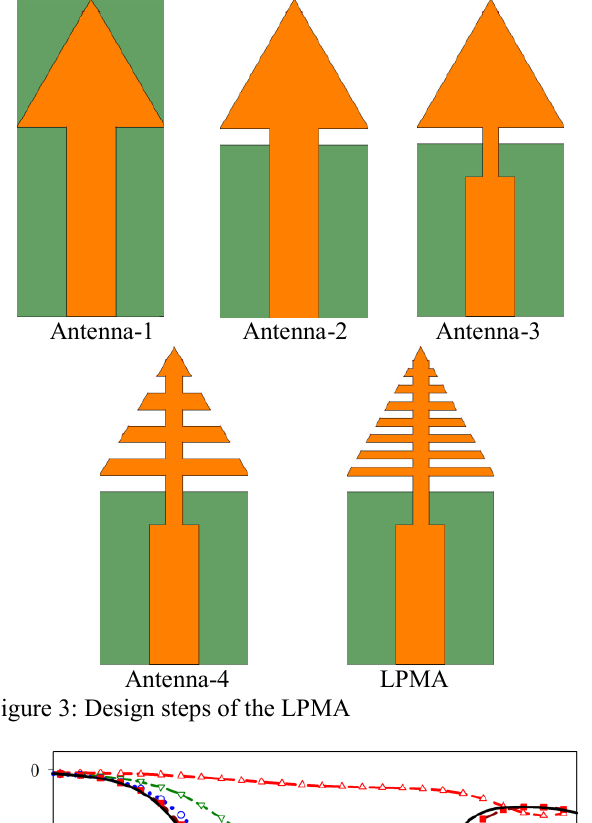
In figure 6, the red dotted lines ( ) show simulated gains while the black solid lines